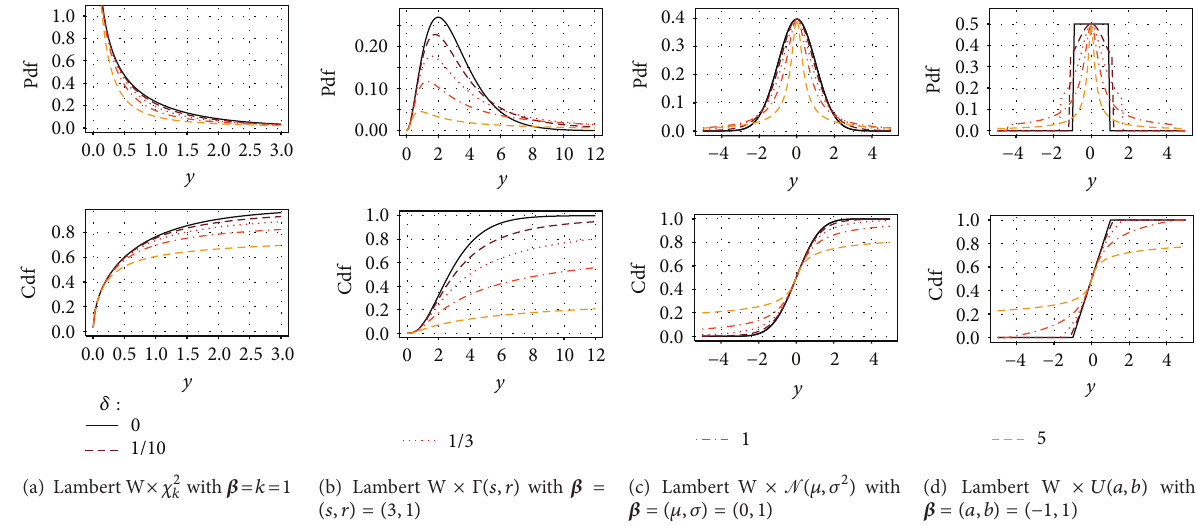
Figure 4: Pdf (left) and cdf (right) of a heavy tail (a) “noncentral, nonscaled,” (b) “scale,” and (c and d) “location-scale” Lambert W × 𝐹 𝑋 random variable 𝑌 for various degrees of heavy tails (color, dashed